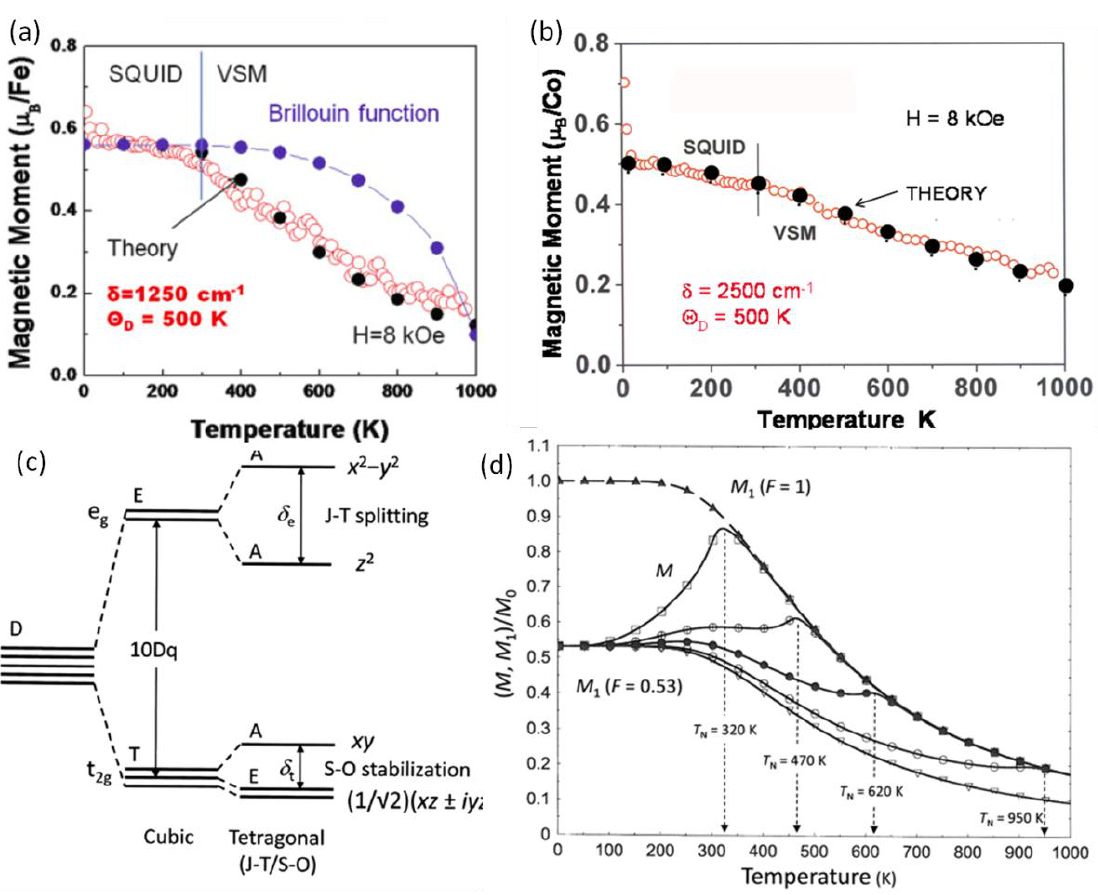
Figure 6. M - T curve of ( a ) STF35 and ( b ) STC23 films and the theoretical fitting using s Equation (2) or the Brillouin function in ( a ); ( c ) The crystal-field energy-level diagram of a 3d ion in an oxygen octahedron subject to in-plane biaxial compressive stress producing a tetragonal (Jahn-Teller type) distortion, where 10 Dq, δ and δ stand for the crystal field t e splitting energy between e and t orbitals, the splitting energy of t orbitals due to g 2 g 2g spin-orbital coupling (S-O stabilization), and the splitting energy of e orbitals due to g Jahn-Teller effect (J-T stabilization); ( d ) Computed M - T curves for a series of Neel temperatures with F = 0.53 using the generic model described by Equation (3), where M , 1 F , T stands for moment of “isolated” ions, population of “isolated” ions and the Neel N temperature respectively [96,97,101]. (Reprinted with permission from